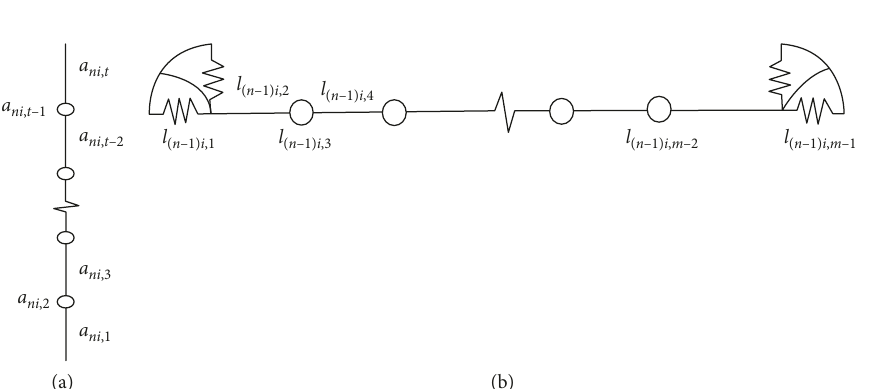
Figure 4: Frame structure mechanics